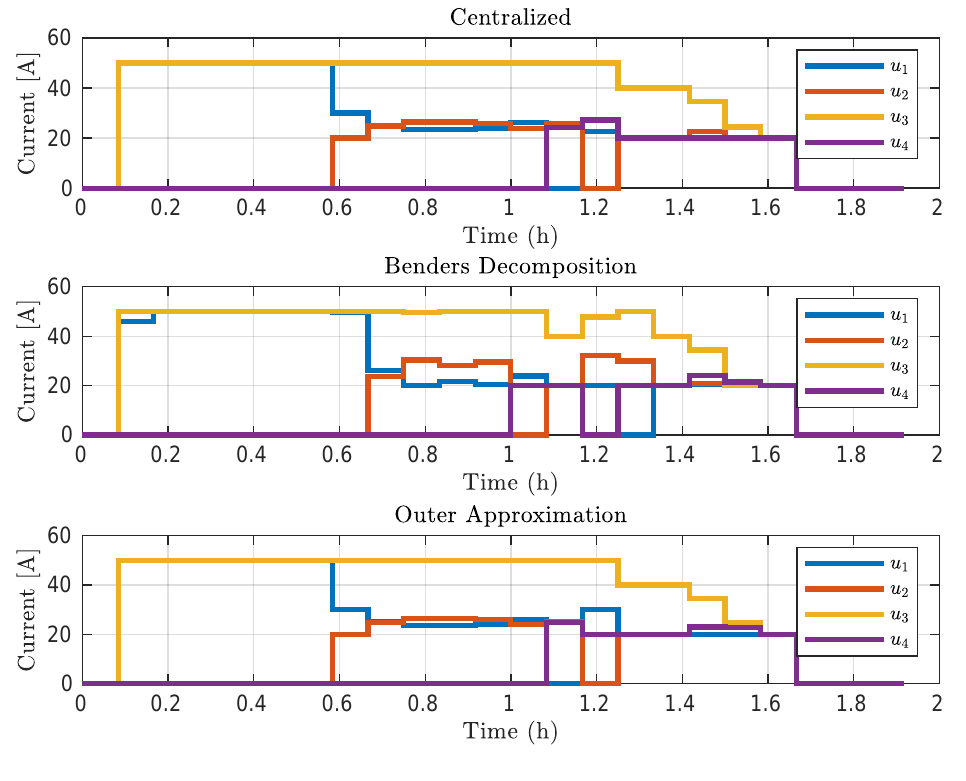
Figure 7. Control signals applied to the